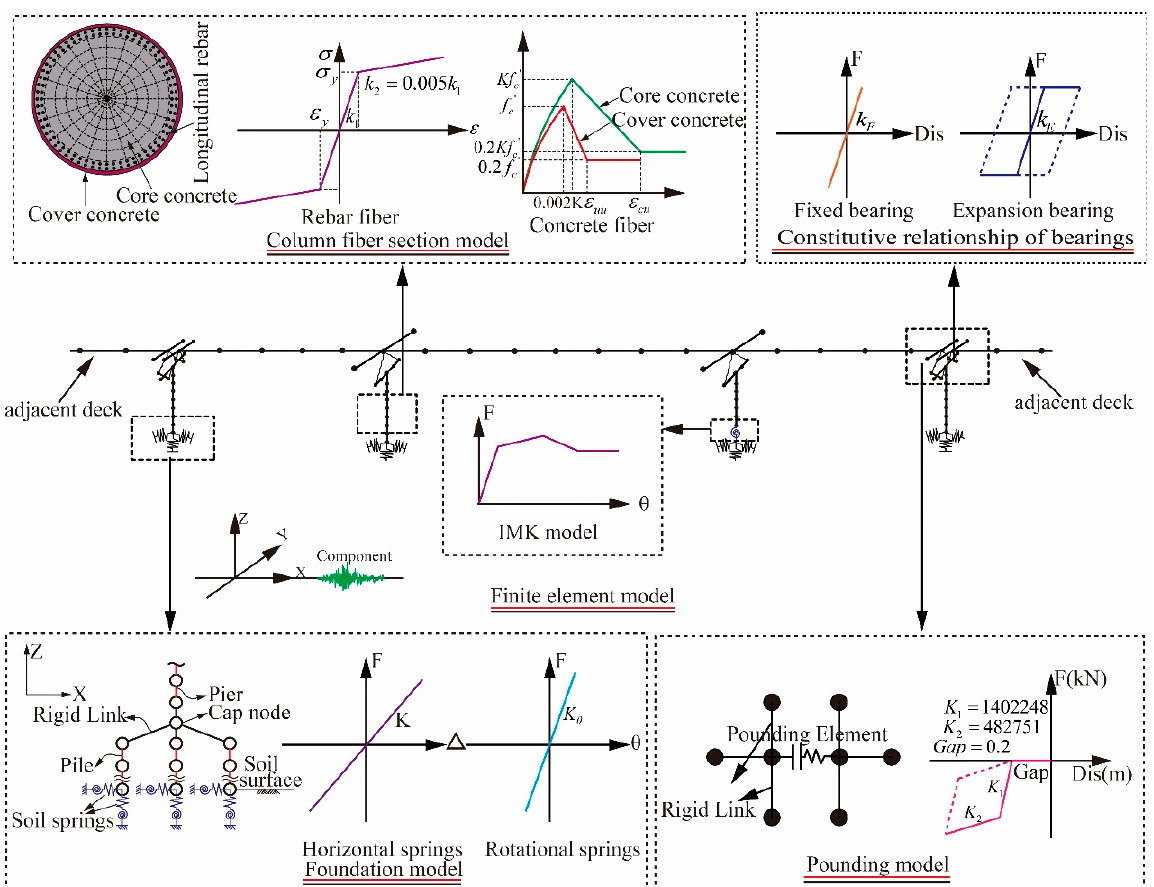
Figure 8. Numerical model of the bridge and its various components.